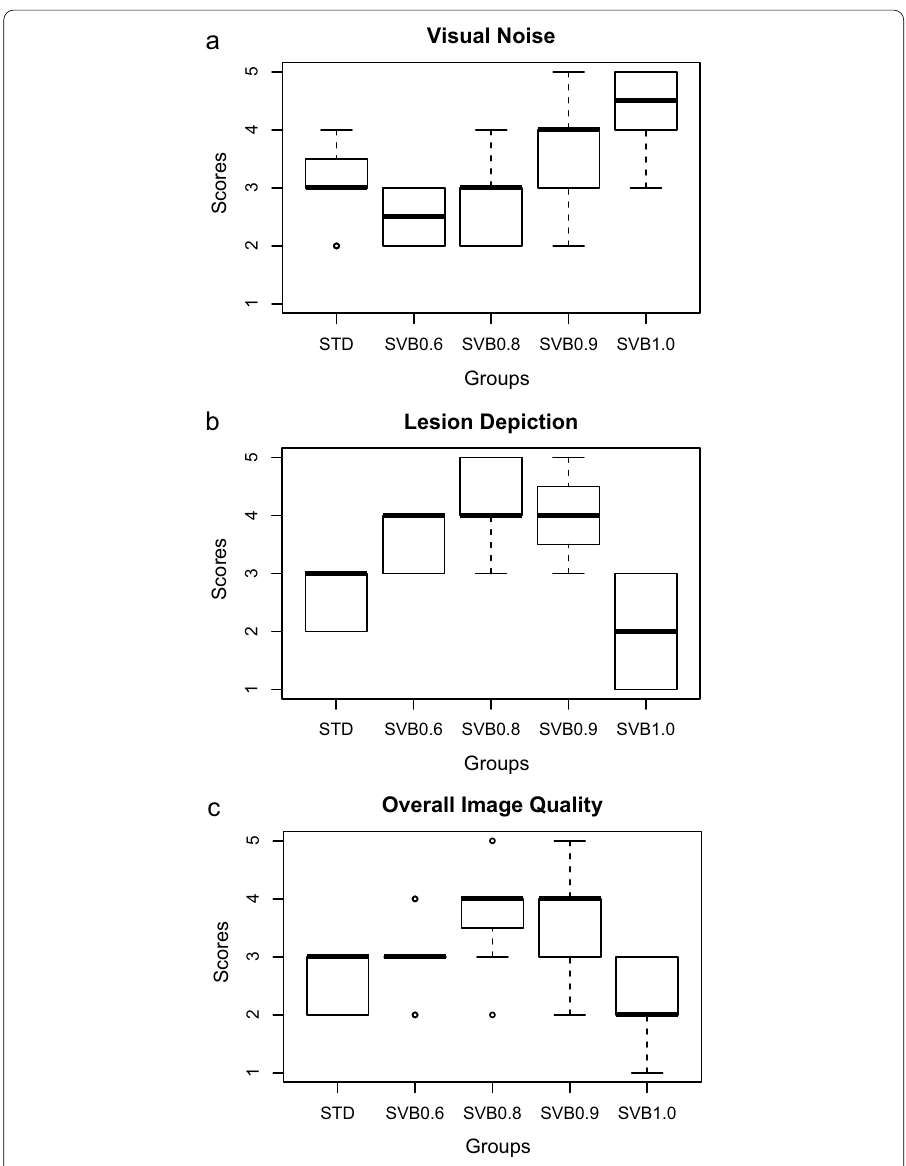
Fig. 3 Visual image scores. a Image noise; b lesion depiction; c overall image